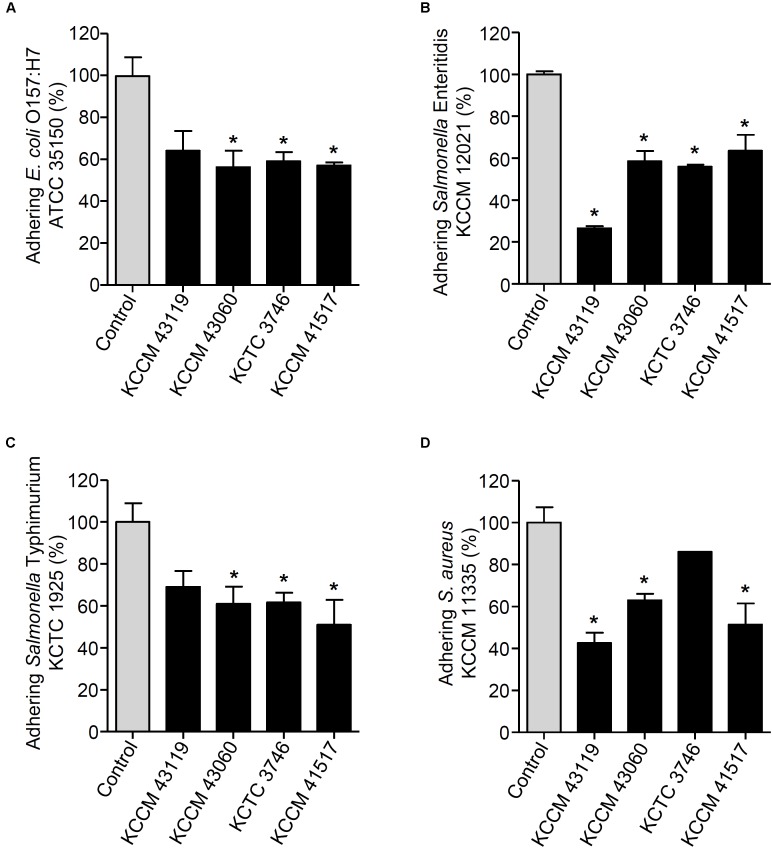
Changes in adhesion of E. coli O157:H7 ATCC 35150 (A), Salmonella Enteritidis KCCM 12021 (B), Salmonella Typhimurium KCTC 1925 (C), or S. aureus KCCM 11335 (D) to HT-29 cells. HT-29 cells were pre-treated with foodborne pathogenic bacteria. After 1 h, the HT-29 cells were treated with the LAB strains (L. curvatus KCCM 43119, Ln. mesenteroides KCCM 43060, W. cibaria KCTC 3746, or W. koreensis KCCM 41517) for an additional 1 h and the adhesion of foodborne pathogenic bacteria was determined. The adhesion of foodborne pathogenic bacteria alone to HT-29 cells was assigned to 100% (control). An asterisk (∗) indicates the statistical significance compared with control (P < 0.05).